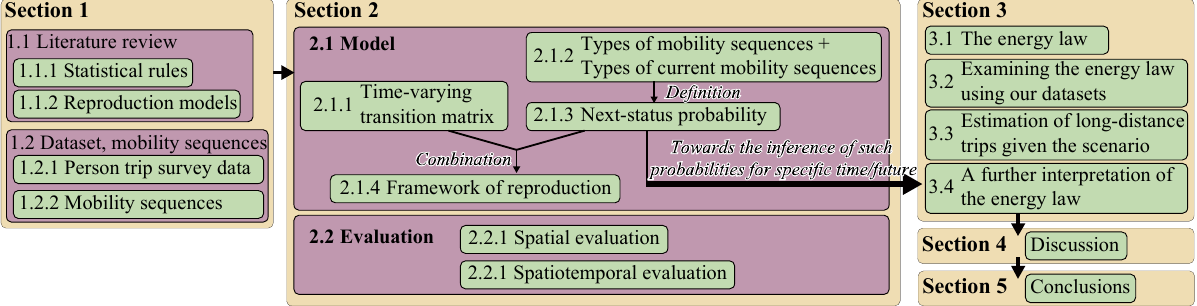
Figure 1. The overall organization of the paper.